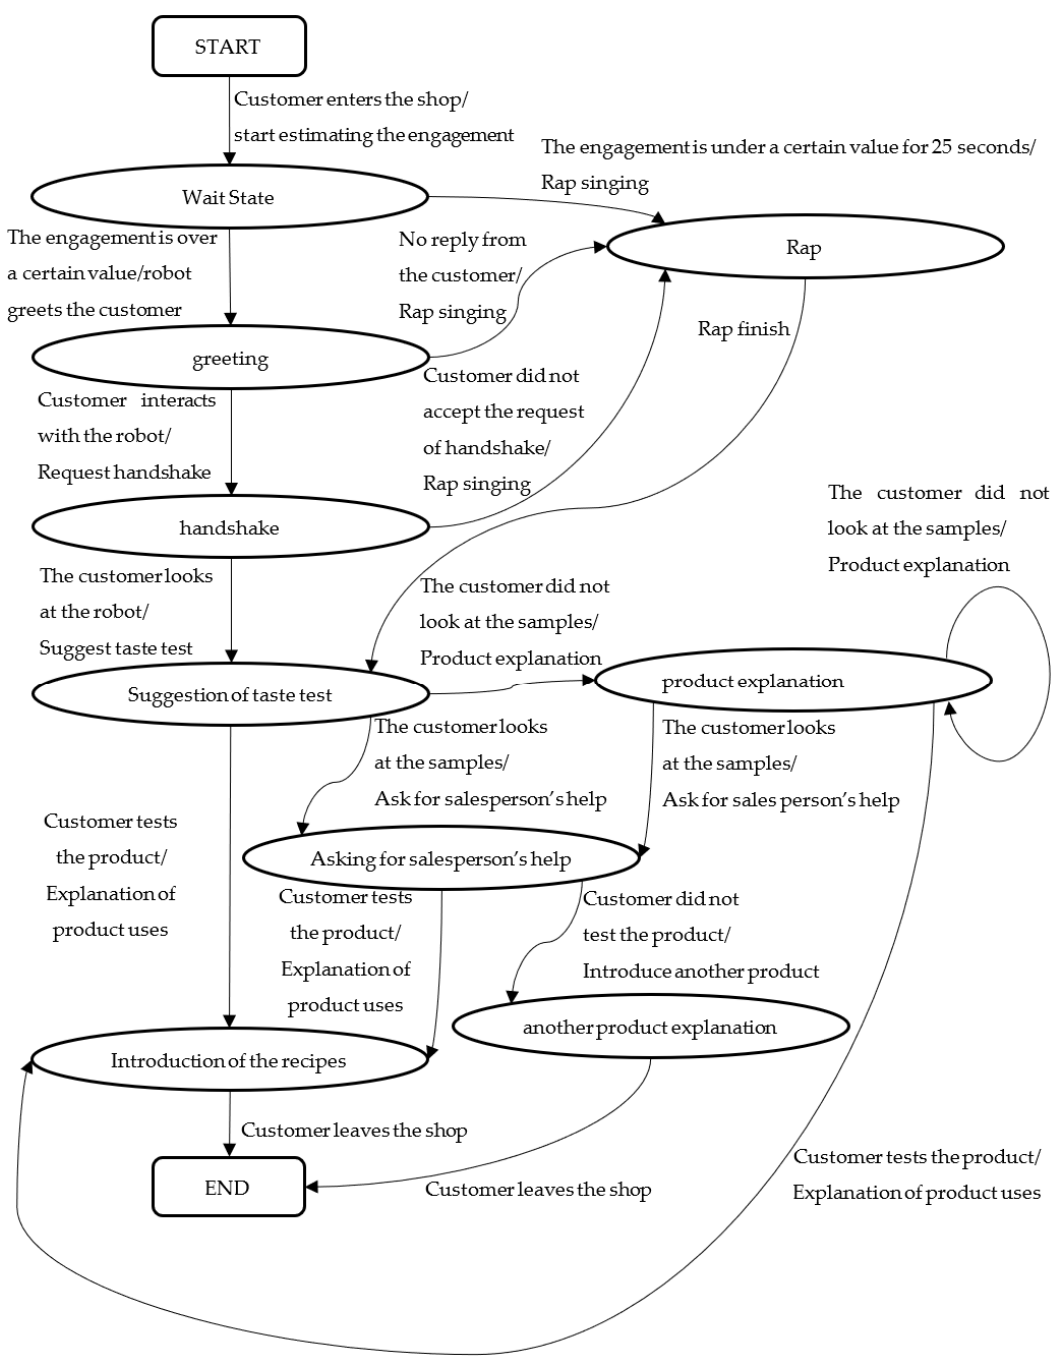
Figure 13. State transition of the interaction between the customers and robot.